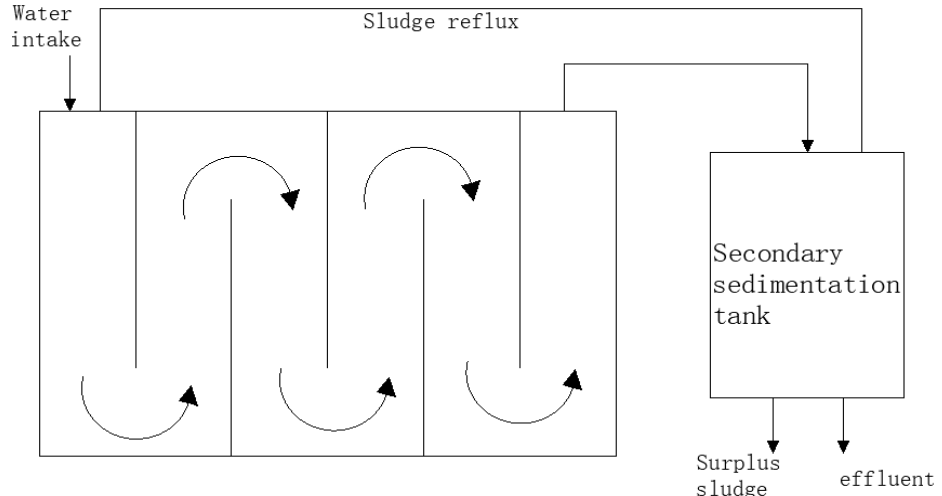
Figure 1. Process flow chart of pushed-flow activated sludge process.